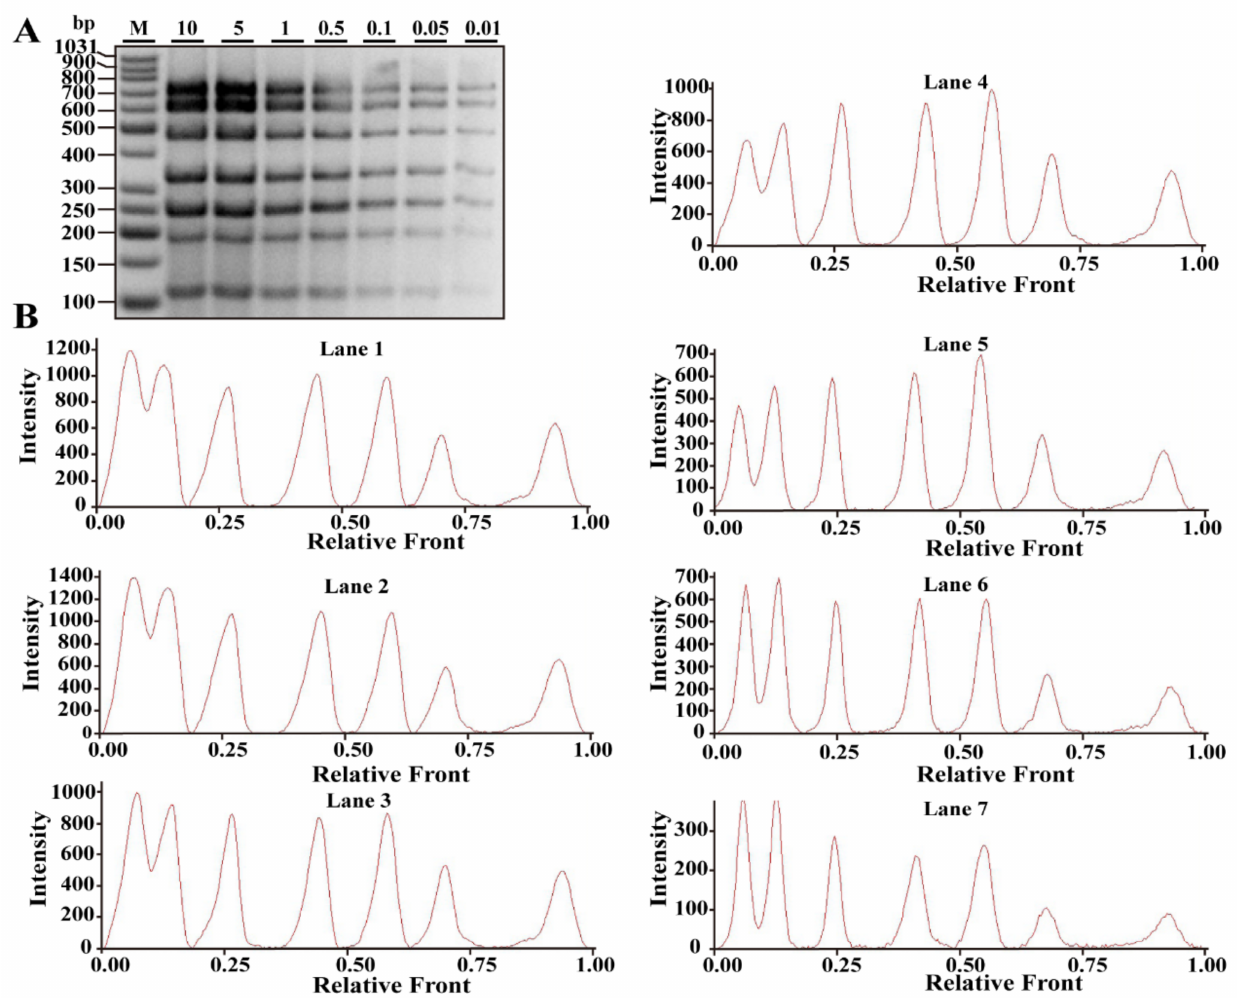
Figure 2. Sensitivity of the developed septuple PCR assay. ( A ) Gel image of the products generated after multiplex PCR amplifications of premixed DNA templates of all species (10, 5, 1, 0.5, 0.1, 0.05, 0.01 ng) with primers of seven meat species mixtures including turkey, goose, pig, cattle, sheep, chicken and duck. ( B ) The corresponding electropherograms of gel image ( A ). Lanes 1–7 are presented with labels (10, 5, 1, 0.5, 0.1, 0.05, 0.01) in ( A ). Lane M is ladder